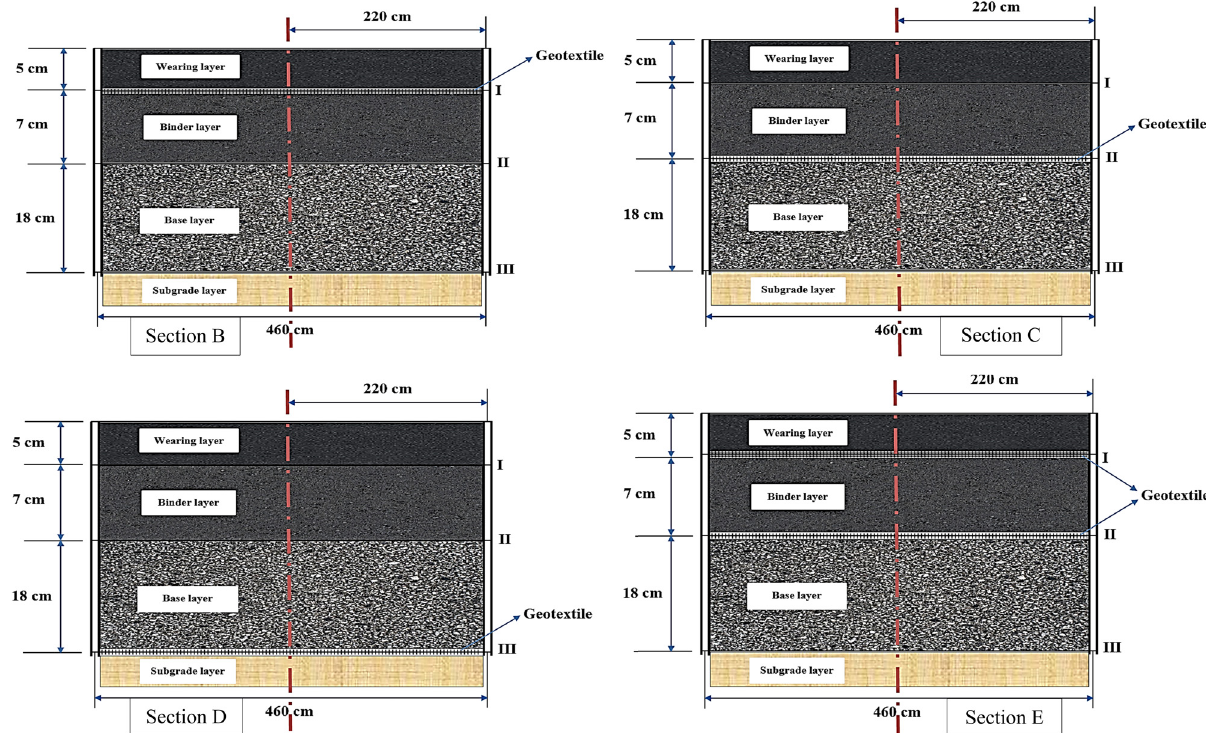
Figure 6: Sections B – E in the constructed road model.